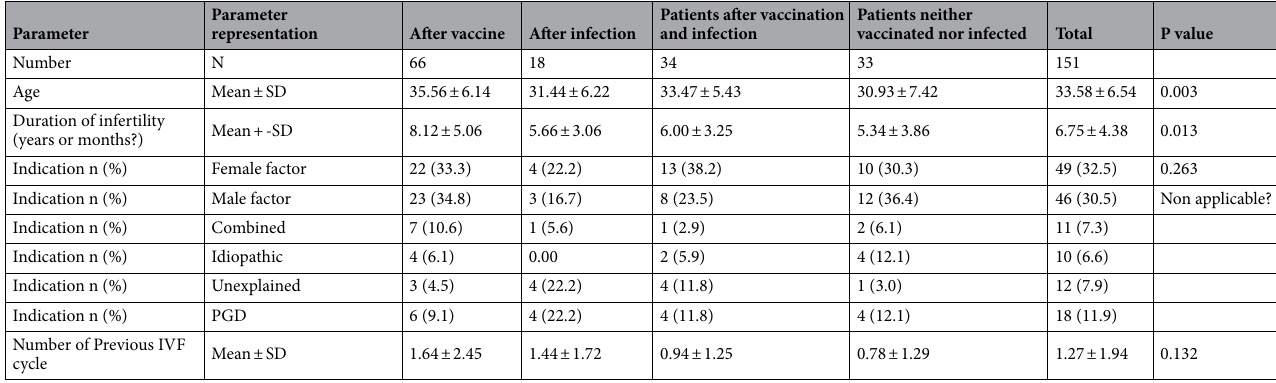
Table 1. Patients’ characteristics. SD standard deviation, PGD preimplantation genetic